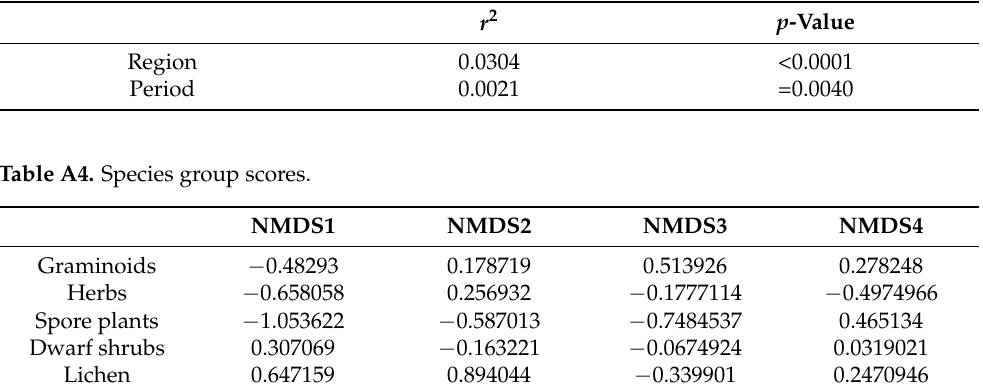
Table A3. Significance test of region and inventory period.